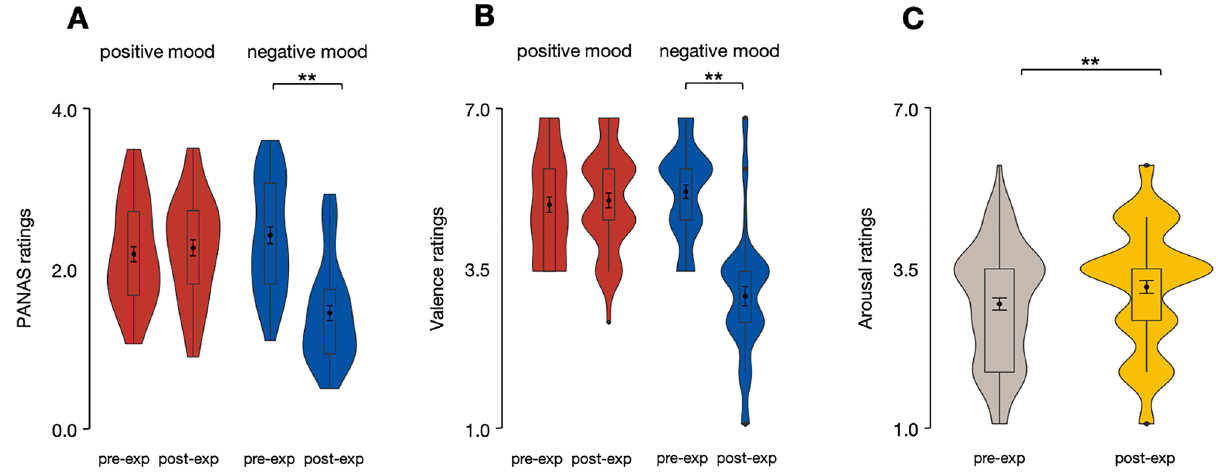
Figure 1. The PANAS ( A ), valence ( B ) and arousal ( C ) ratings pre- relative to post-experiment. Error bars represent 95% confidence